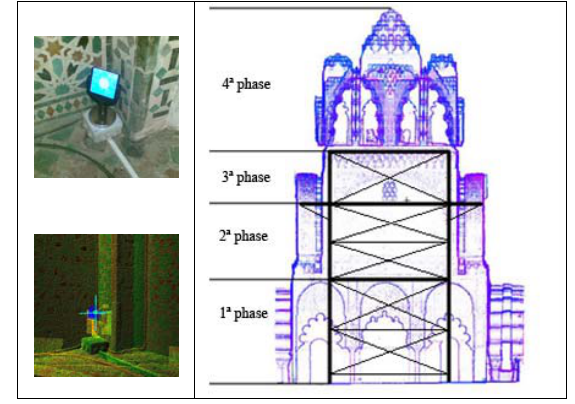
Figure 4. Left: circular targets employed for point cloud registering. Right: scanning phases as scaffolding stages were being